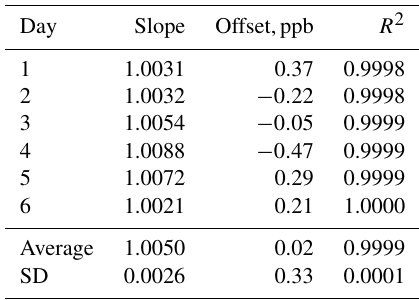
Figure 3. Measured output of a Model 306 Ozone Calibration Source where the ozone mixing ratio was systematically varied in steps of 50 and 200ppb (30 points = 5min), as described in the text.